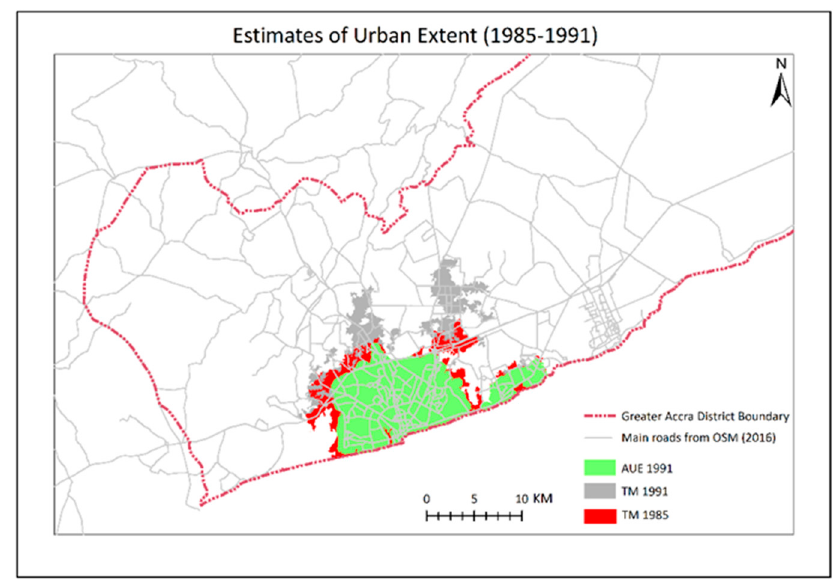
Figure 4. Estimates of the spatial extent of the Accra agglomeration for the period (2000–2002). Contributing datasets: Atlas of Urban Expansion (AUE) and Landsat-TM texture (TM). Road network from OpenStreetMap 2016 (https:/www.openstreetmap.org).